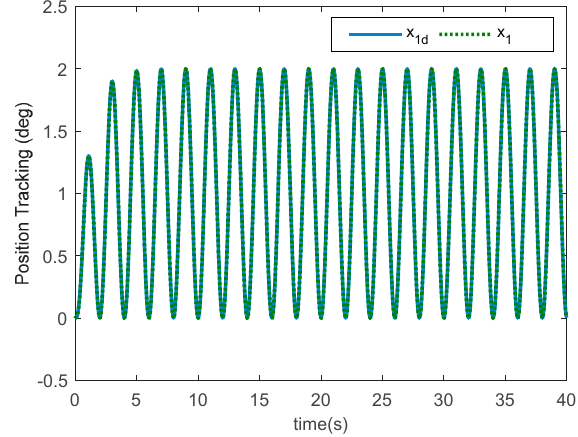
Figure 9. The position tracking of ARCBF in case 2.